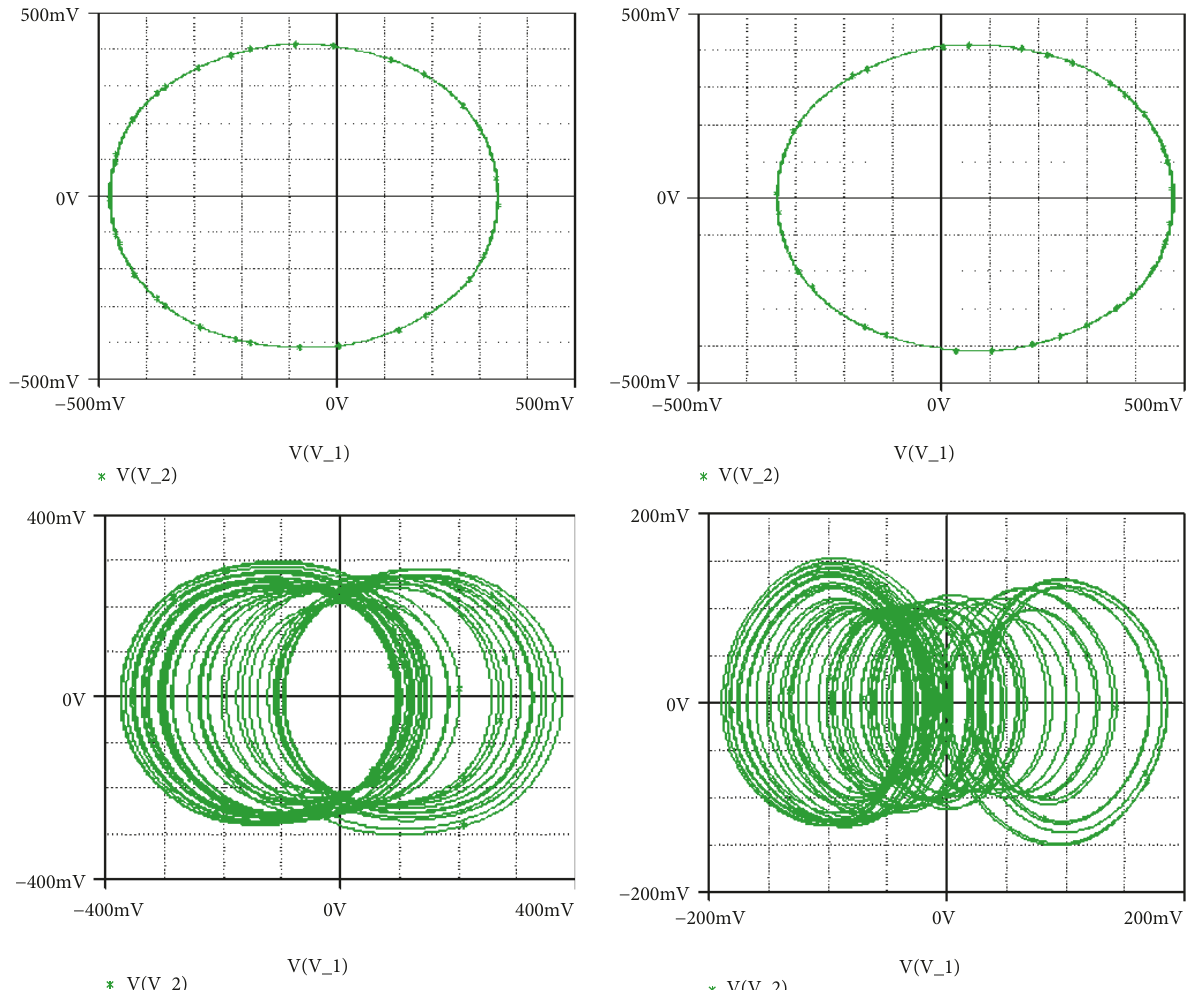
Figure 14: Pspice simulation results showing the coexistence of four different attractors for 𝑅𝑎2 = 17.91𝑘Ω (a pair of period-1 limit cycles, and two symmetric chaotic attractors). Initial states are indicated in Table